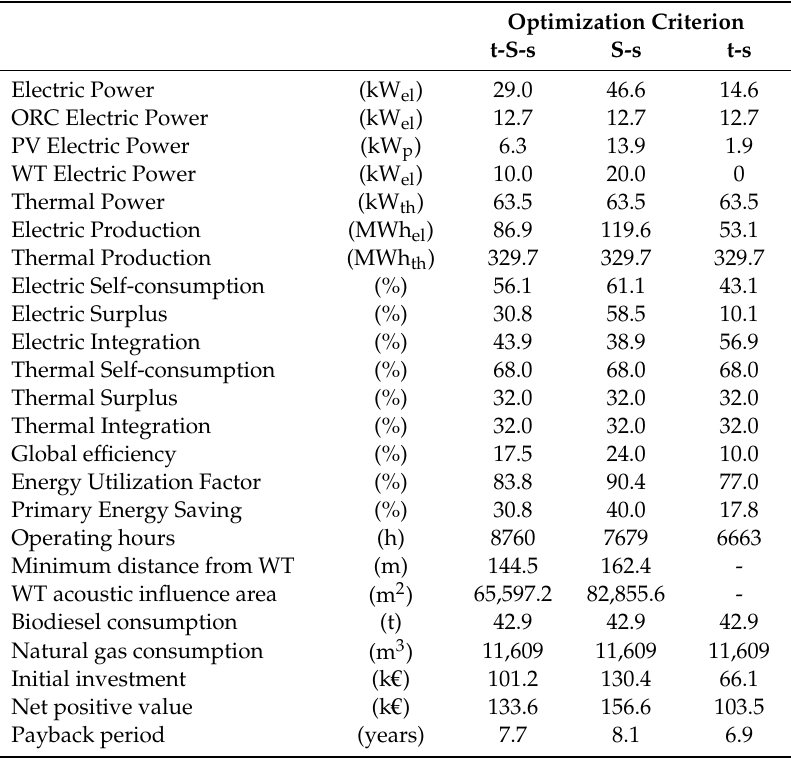
Table 5. Optimized multi-source integrated